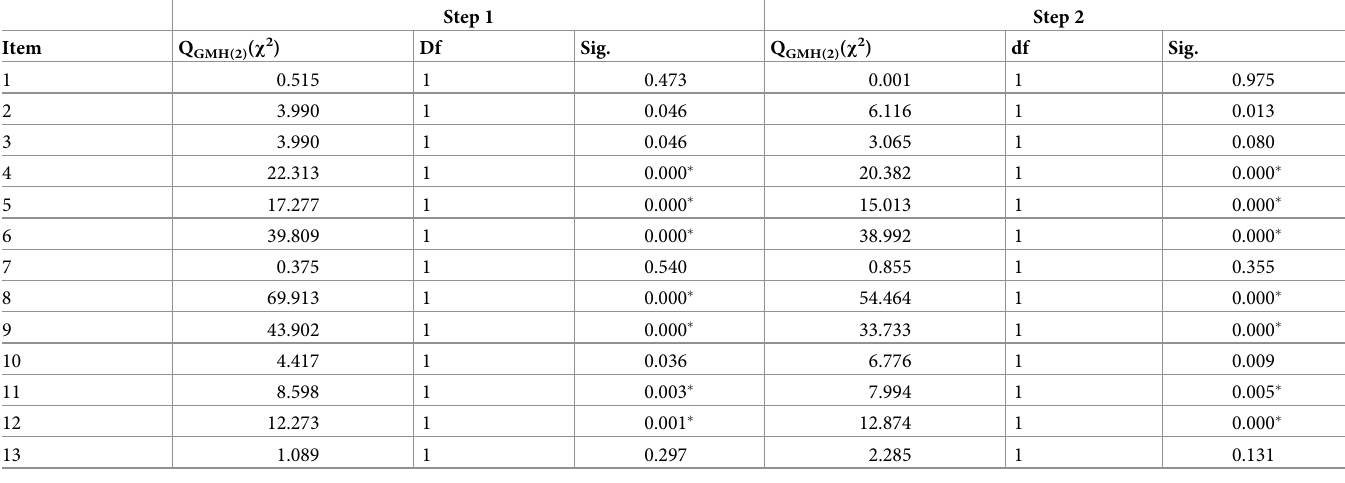
Table 1. DIF analysis using the generalized Mantel Haenszel Method.